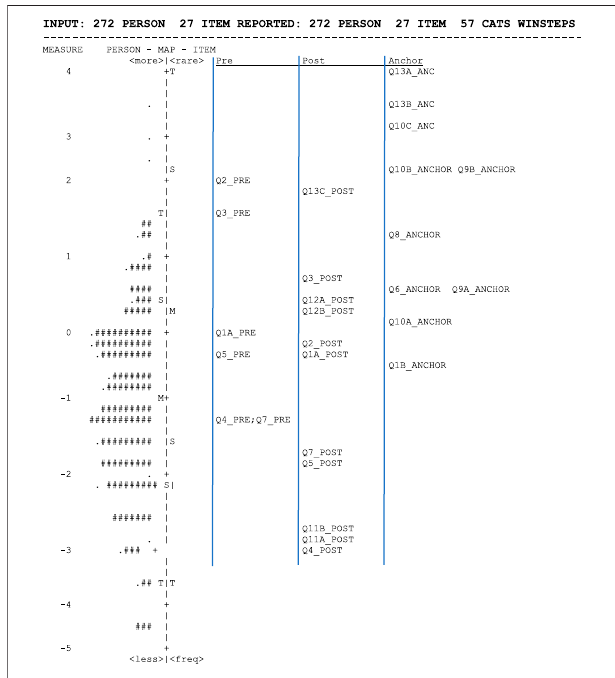
FIGURE 2 | Person-Item measure for post-test